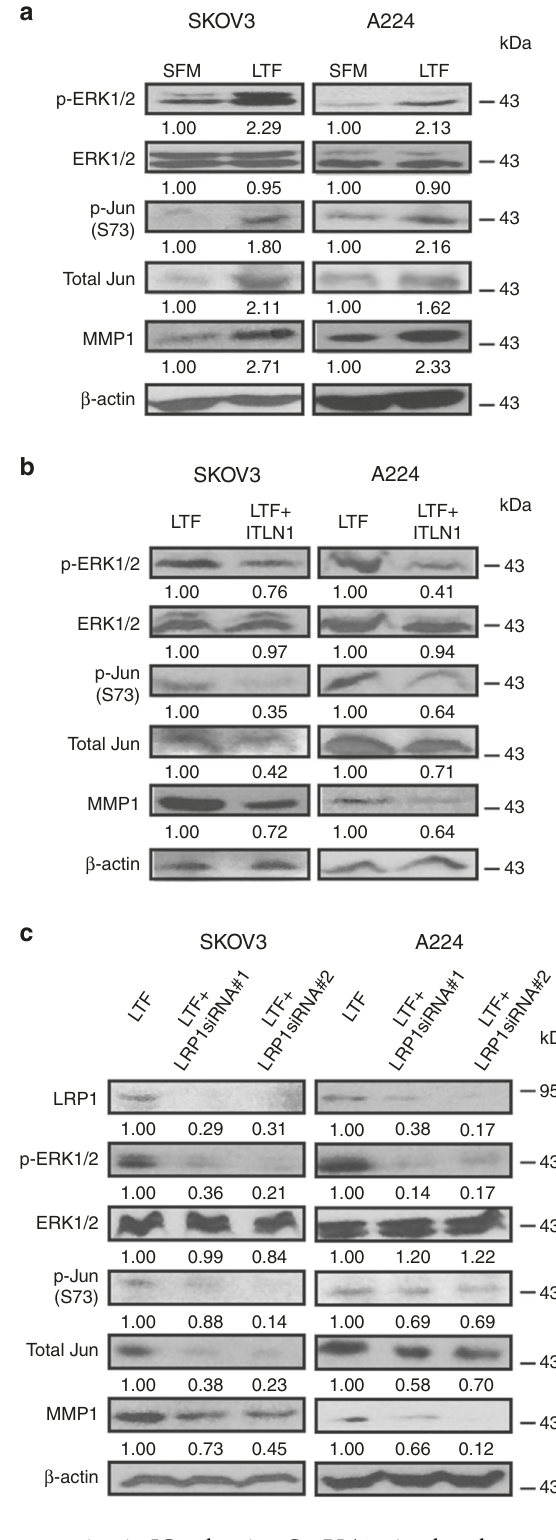
Fig. 5 ITLN1 inhibits the LTF/LRP1/MMP1 signaling pathway. Western blot analyses show ( a ) higher protein levels of p-ERK1/2, p-Jun (S73), total Jun, and MMP1 in LTF-treated (100 μ g mL − 1 ) SKOV3 and A224 compared with control cells without treatment; b lower protein levels of p-ERK1/2, p- Jun (S73), total Jun, and MMP1 in LTF-treated SKOV3 and A224 with ITLN1 (500 ng mL − 1 ) compared with control cells without ITLN1; and c lower protein levels of LRP1, p-ERK1/2, p-Jun (S73), total Jun, and MMP1 in